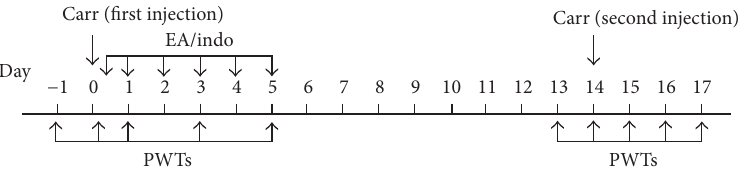
Figure 1: Flow chart of the procession of a pain memory model and intervening measures. The pain memory model was induced by two injections of carrageenan. The first inflammatory reaction was induced with carrageenan injection in the left hind paw at day 0. The paw withdrawal thresholds (PWTs) at days − 1, 0, 1, 3, and 5 were recorded and that the one at day − 1 was regarded as the baseline value. The EA/indo interventions were administered at 5 h, 1–5d after the first carrageenan injection. The second inflammatory reaction was induced by injection in the right hind paw at day 14. The PWTs at day 13 through 17 were recorded and the one at day 13 was regarded as the new baseline value. The PWTs of the left (uninjected in the second injection of carrageenan) hind paw on day 15 through 17 manifested the memory of pain.